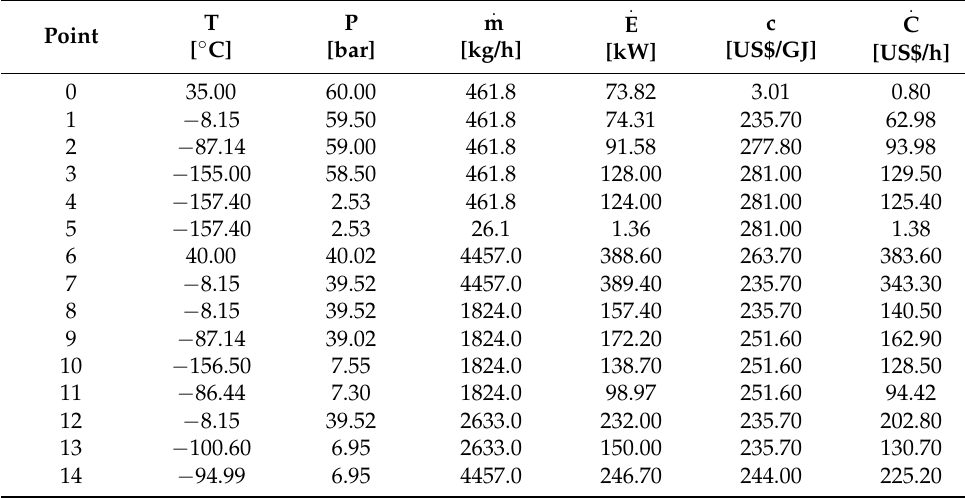
Table 4. Thermodynamic, exergy, and exergoeconomic performance